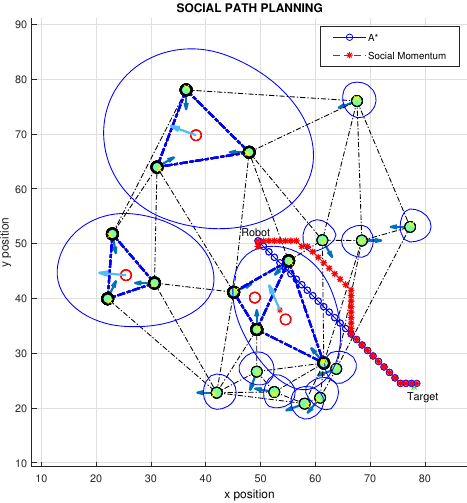
Figure 16. Proposed path planning method.